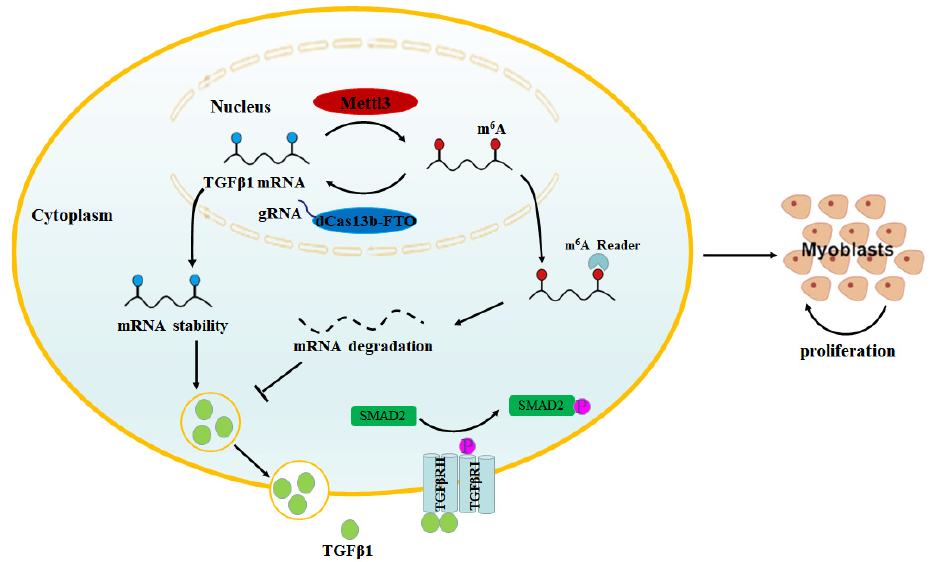
Figure 7. Graphical representation of the mechanisms underlying m 6 A of TGF β 1 regulating myoblast proliferation. Targeted demethylation of the TGF β 1 mRNA could increase the mRNA stability and expression of TGF β 1, and then activate the TGF β signaling pathway, thereby promoting my- oblast